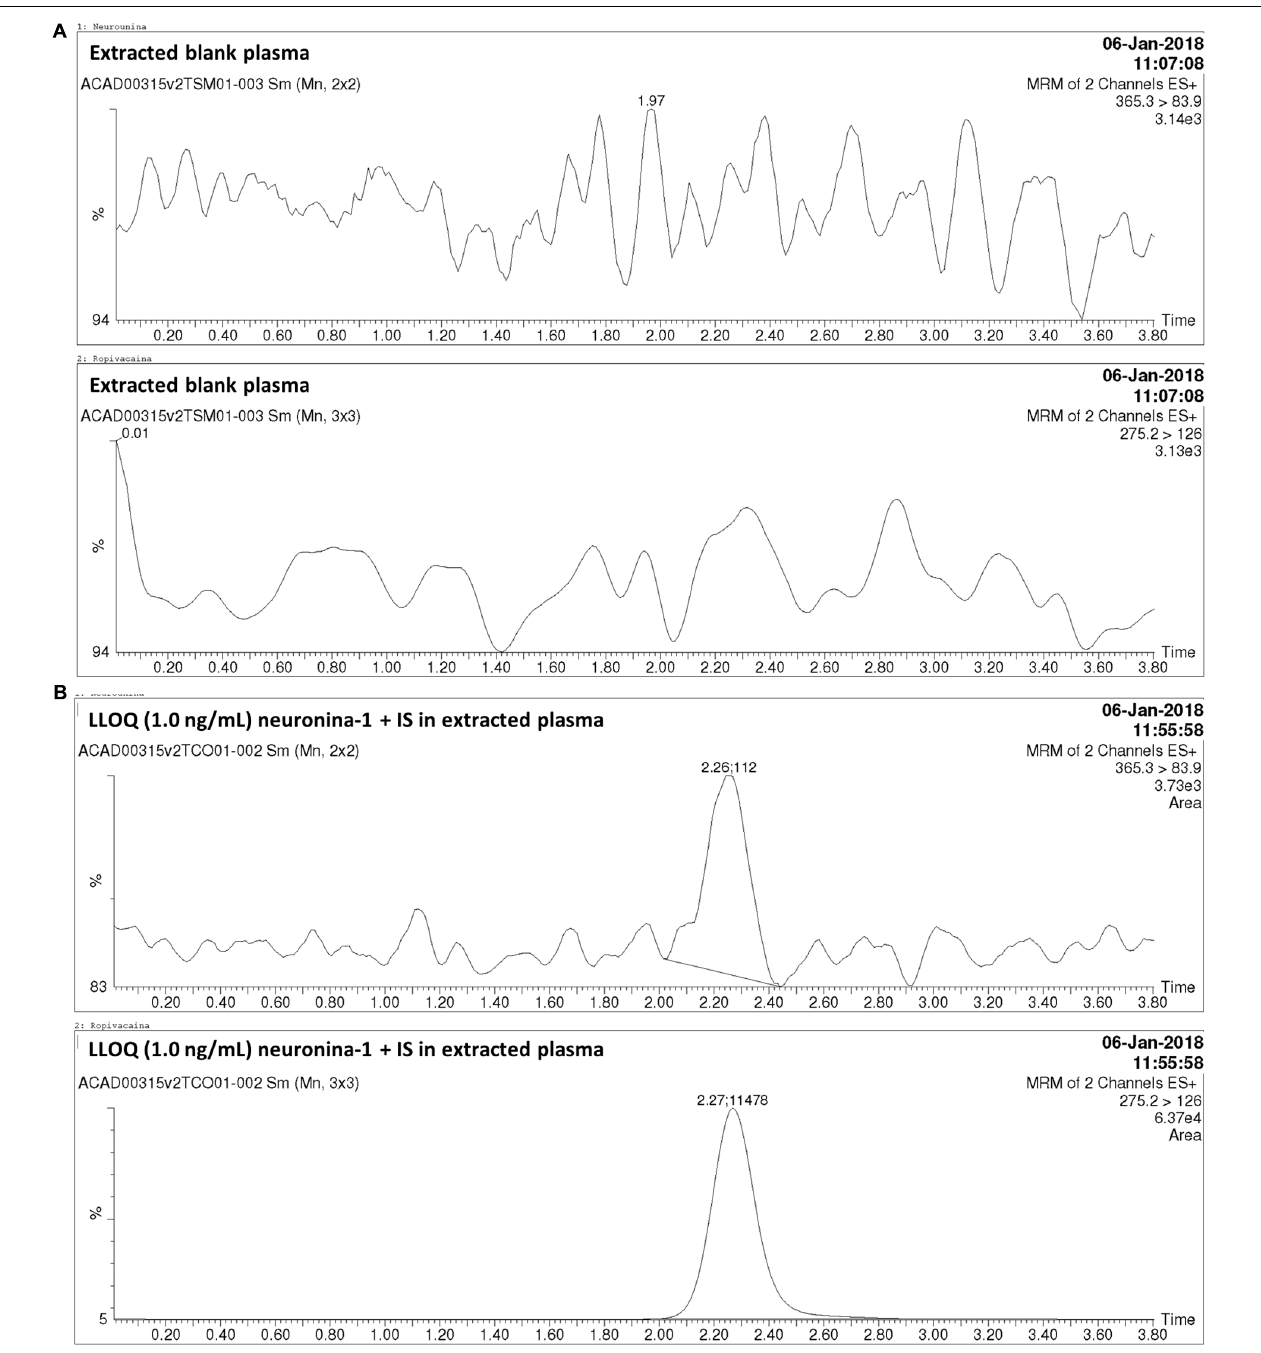
FIGURE 2 | Chromatograms obtained in the analysis of neurounina-1 in beagle dog plasma. (A) Blank beagle dog plasma; (B) Blank beagle dog plasma spiked with neurounina-1 (lower limit of quantification (LLOQ – 1.0 ng/mL) and ropivacaine (internal standard – IS, 100 ng/mL).